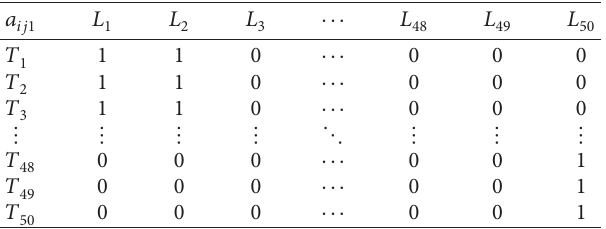
Table 9: Profit and loss matrix D transportation